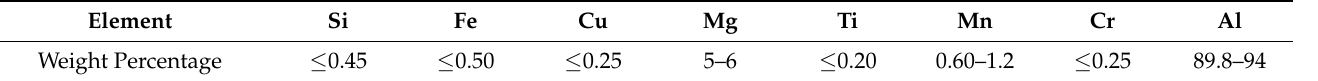
Table 1. Chemical composition of